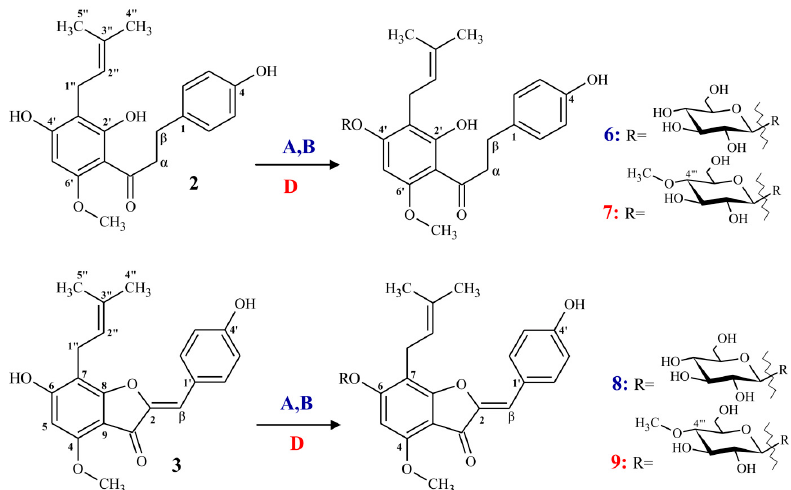
Figure 3. Fungal transformations of prenylated flavonoids 1-3 catalyzed by: ( A ) Absidia coeruela AM93; ( B ) Absidia glauca AM177; ( C ) Rhizopus nigricans UPF701; ( D ) Beauveria bassiana AM278; and ( E ) B. bassiana AM446.